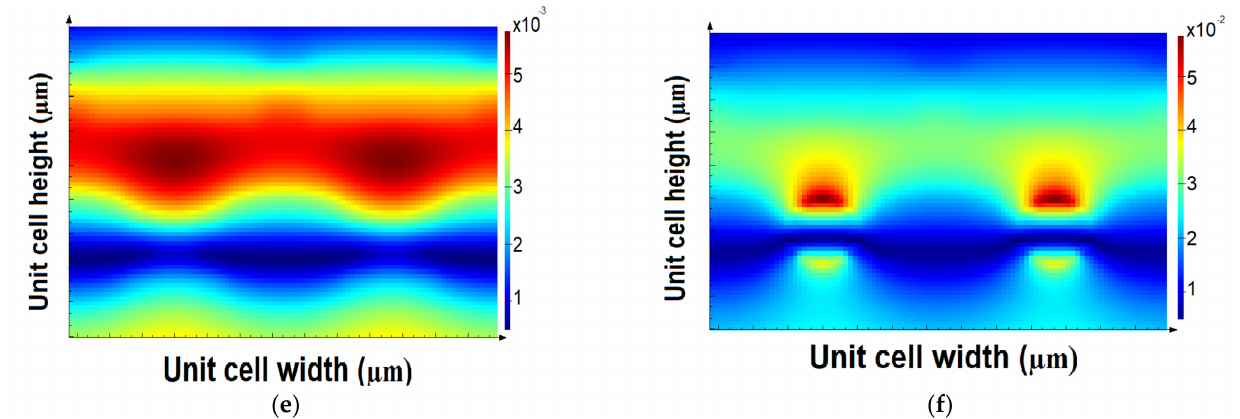
Figure 10. Optical power distribution on vertical planes ( a ) for the first monitor, M 1 ( b ) for the second monitor, M 2, electric field distribution ( c ) for the first monitor, M 1 ( d ) for the second monitor, M 2, and magnetic field distribution ( e ) for the first monitor, M1 and ( f ) for the second monitor, M